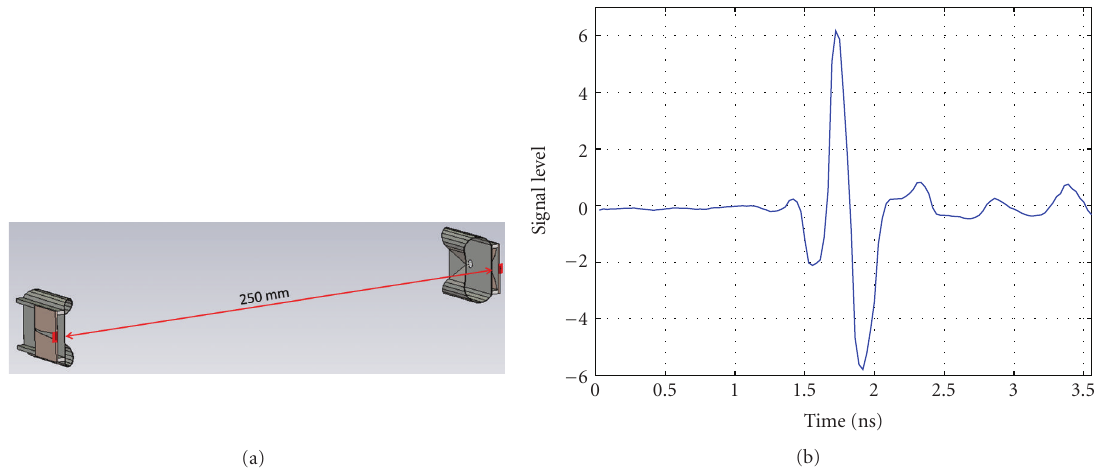
Figure 3: Measured time-domain impulse response of the UWB radar system when the two antennas are separated by 250 mm in the face-to-face configuration.